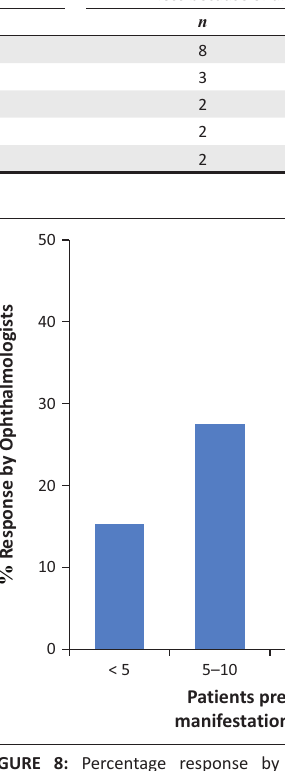
TABLE 3: Percentage of patients presenting with diabetic retinopathy on first visit and percentage who have lost vision in one eye because of diabetic retinopathy. Percentage of patients reported by ophthalmologists ( % )